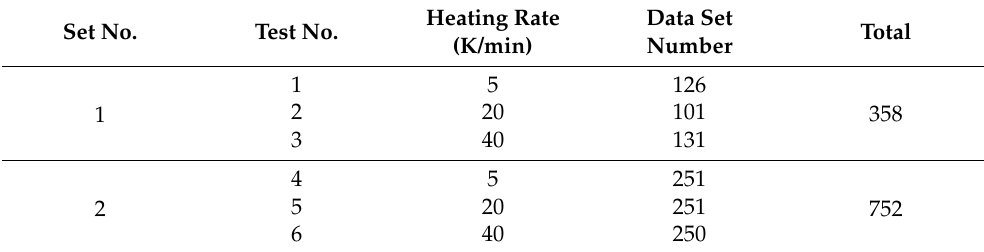
Table 3. Data set number of six tests. Set No.